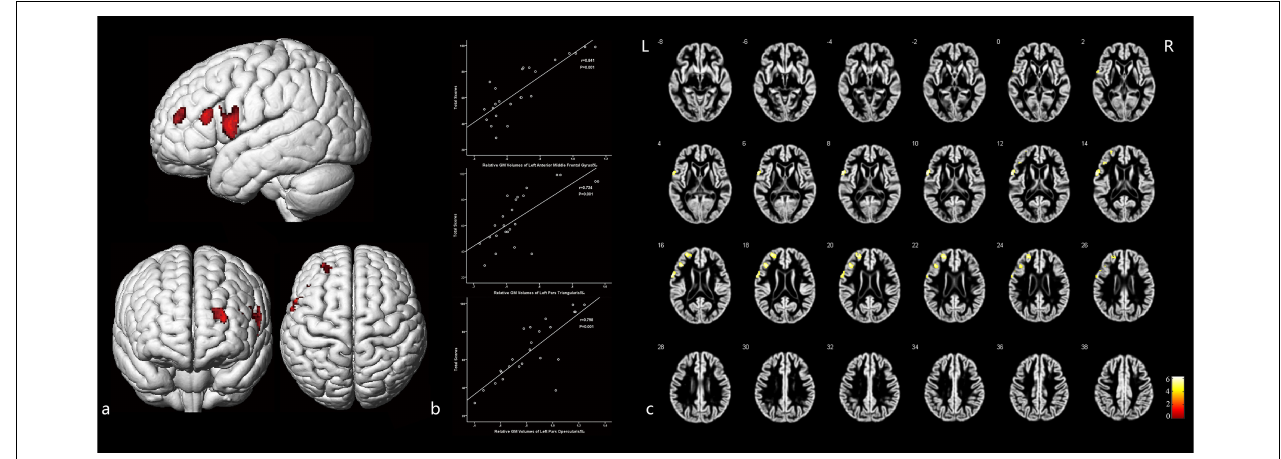
FIGURE 4 | The cortex related with general memory function and their Pearson correlation coefficients. (a) Three-dimensional image. (b) Correlation between the total scores of CMS and regional relative GM volumes. (c) Slice view. GM volumes of the left pars opercularis gyri frontalis inferioris, left pars triangularis gyri frontalis inferioris, and the frontal part of left middle frontal gyrus were positively related with the total clinical memory scores closely. L: left, R: